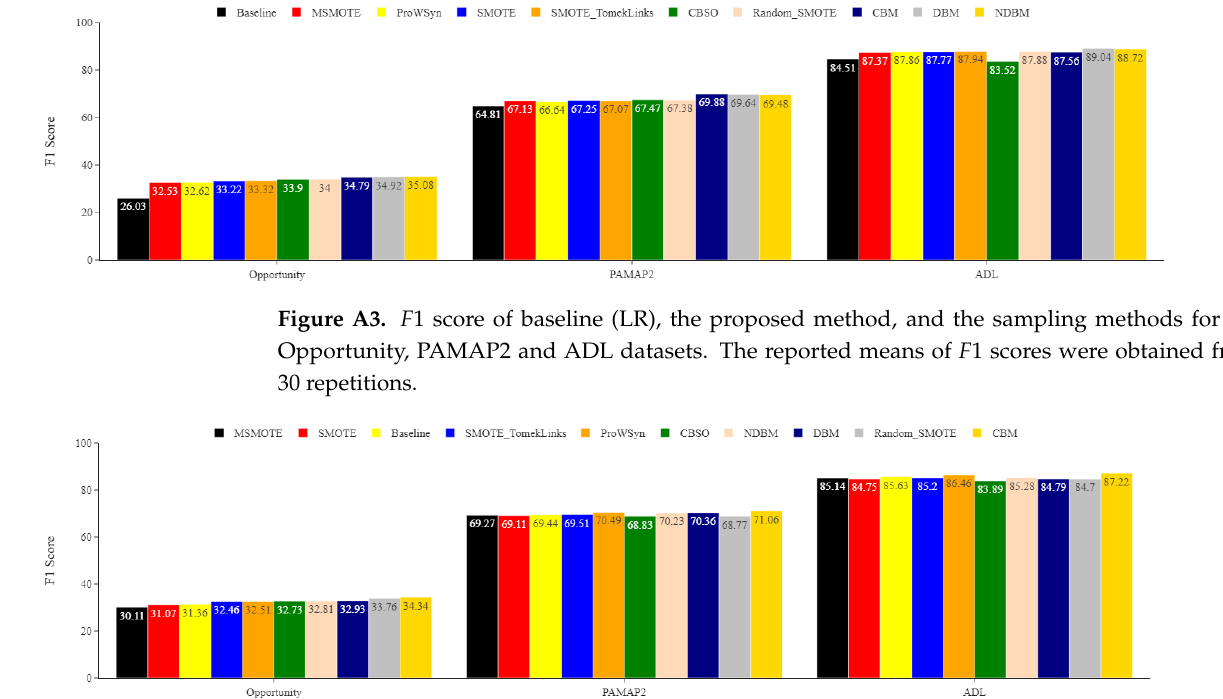
Figure A4. F 1 score of baseline (KNN), the proposed method, and the sampling methods for the Opportunity, PAMAP2, and ADL datasets. The reported means of F 1 scores were obtained from 30